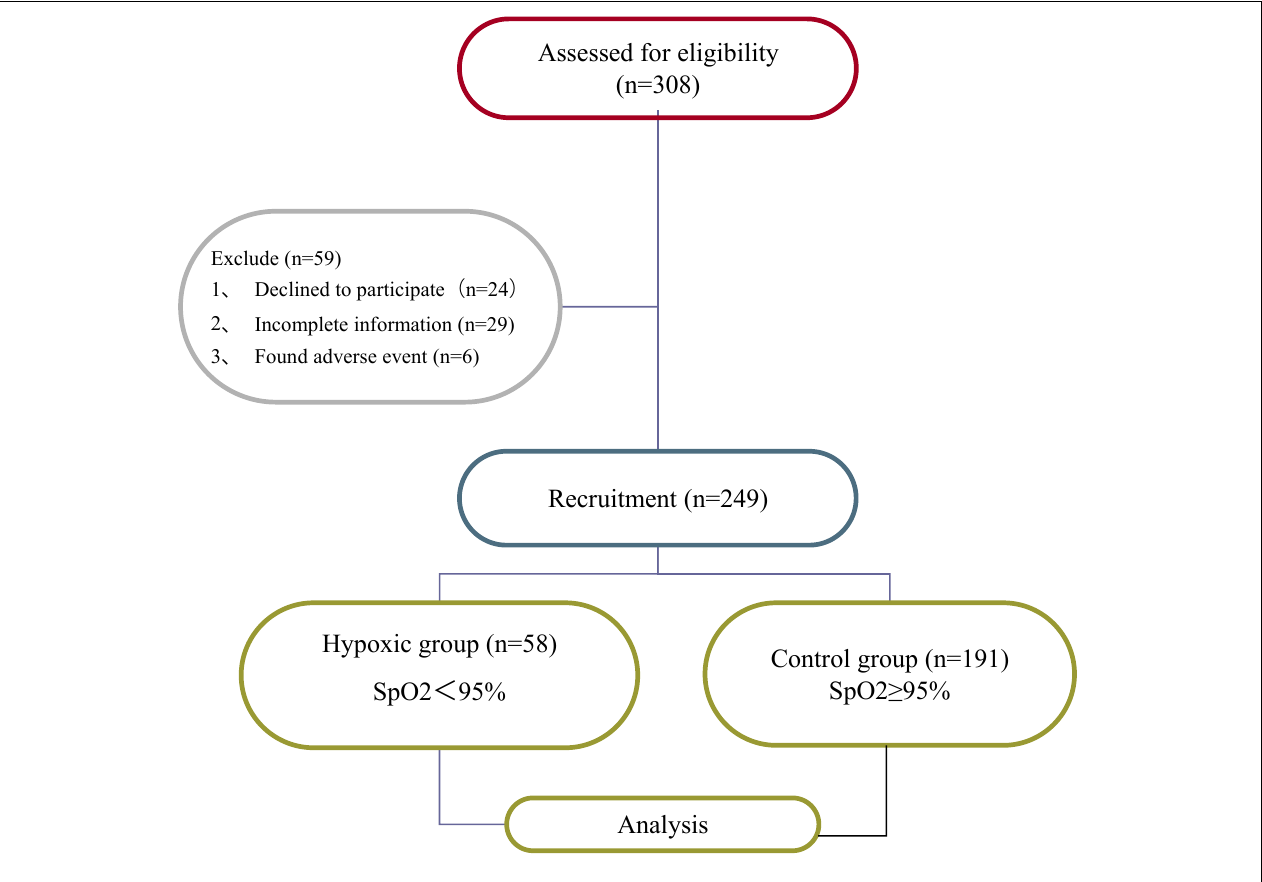
FIGURE 1 | Flow diagram showing enrolled and excluded patients.